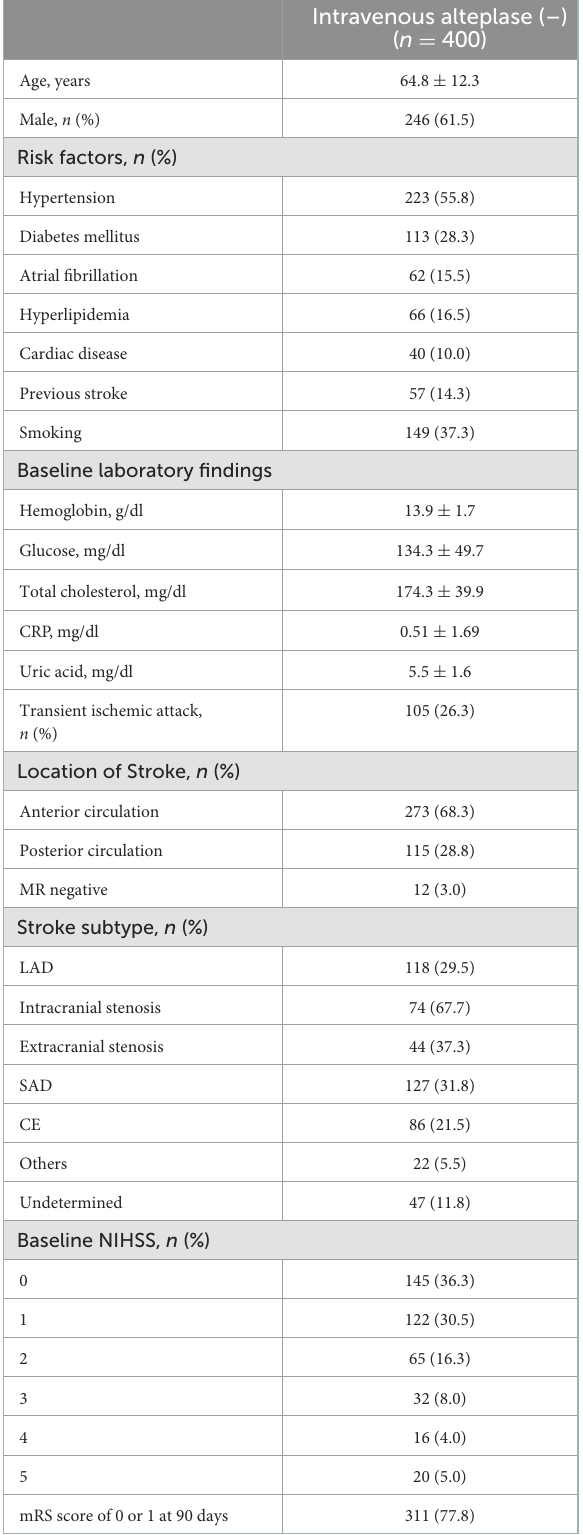
TABLE 1 Baseline characteristics of this